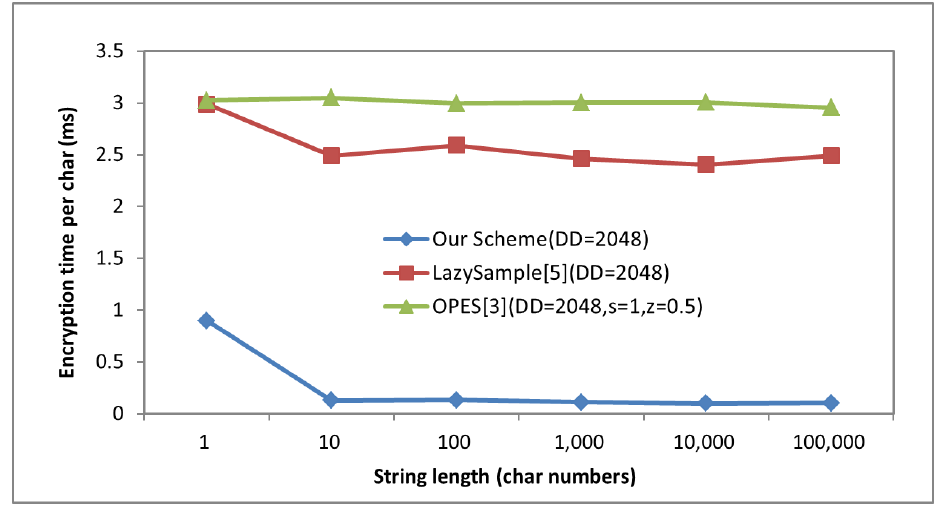
Figure 4. The encryption time of single character with different string length.